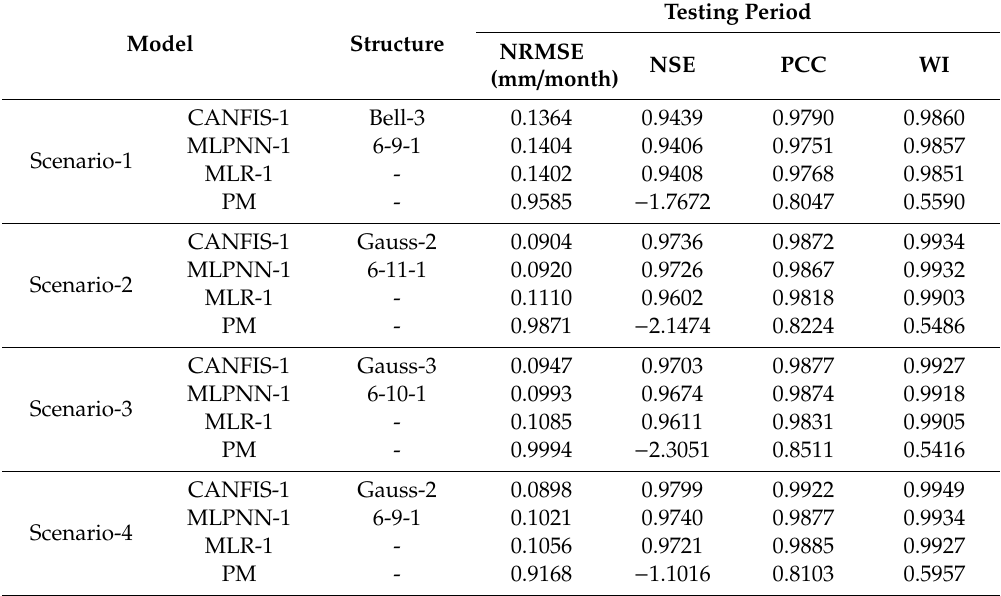
Table 5. Normalized root mean square error (NRMSE), Nash–Sutcli ff e e ffi ciency (NSE), Pearson correlation coe ffi cient (PCC), and Willmott index (WI) values of CANFIS, MLPNN, multiple linear regression (MLR), and Penman model (PM) models during the testing period at Pantnagar station under four di ff erent